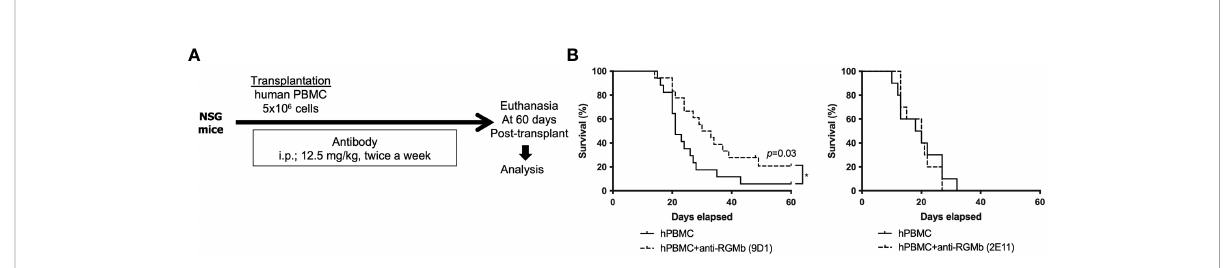
FIGURE 4 Anti-RGMb antibody therapy with 9D1 but not 2E11 ameliorates xenograft GvHD in mice. (A) To assess the impact of anti-RGMb antibody treatment in T cell xenoresponse, female NSG mice were irradiated with 250 cGy and subsequently injected with 5x10 6 human PBMCs. On days -1, 3, 7 and 11 after PBMC transfer the RGMb antibody was injected i.p. (12.5 mg/kg). (B) Survival was monitored until 60 days after transplantation. Three independent experiments were done. Results are expressed as mean ± SEM (n=5/group). * p ≤